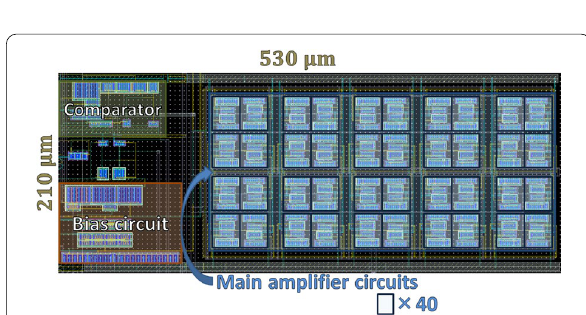
Fig. 4 Physical layout of the proposed high-speed current detection